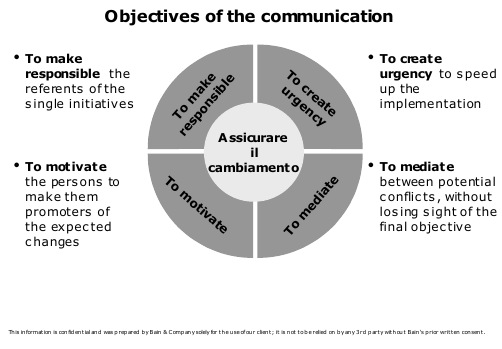
Figure 4 : Role of the Communication in a Change Management Process Figura 4: Ruolo della comunicazione in un processo di